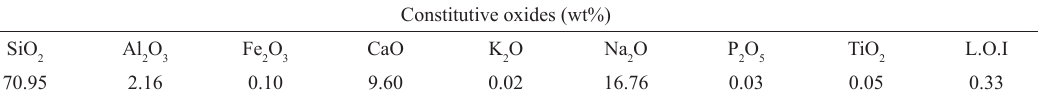
Table 1: Chemical composition of the TGB obtained by XRF. L.O.I: loss on ignition.